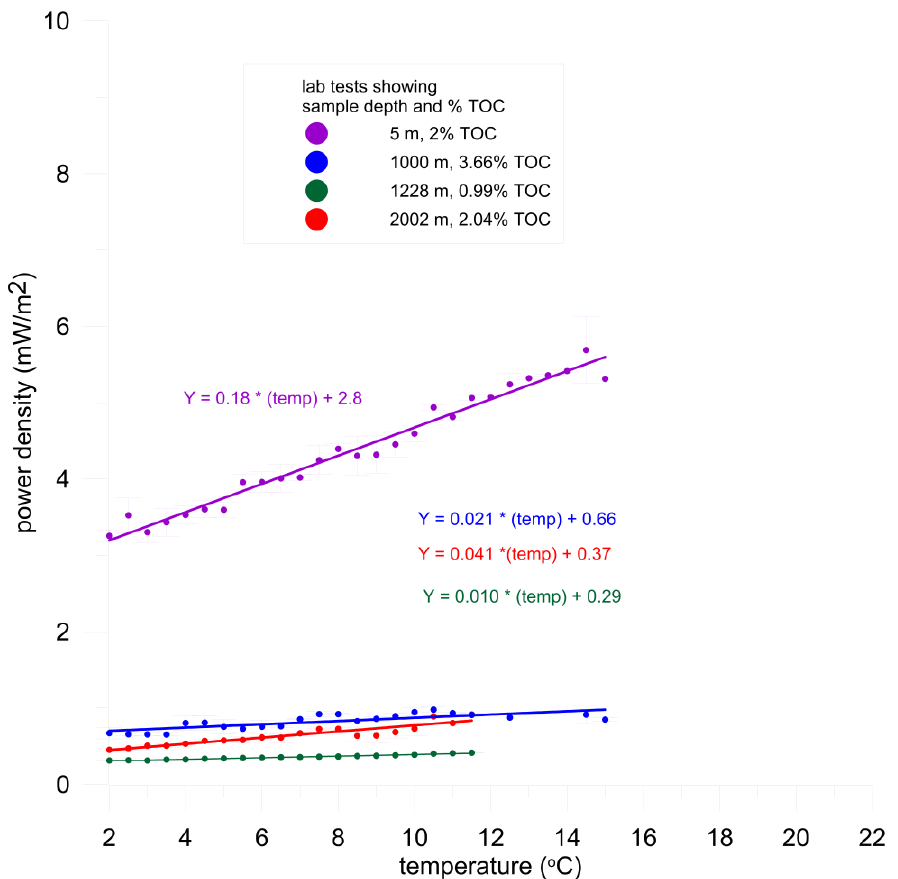
Figure 15. MFC power density versus temperature in deep sediments (bottom three plots) and shallow sediments (top plot).